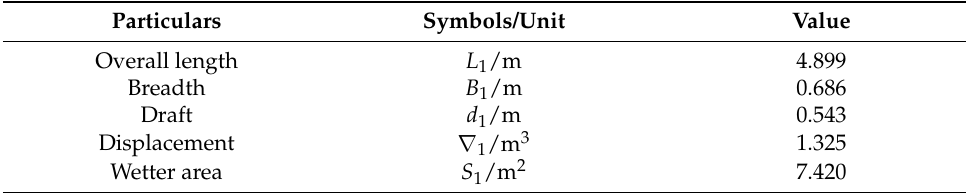
Figure 3. The geometry of the pentamaran. Table 2. Main particulars of the front hull.